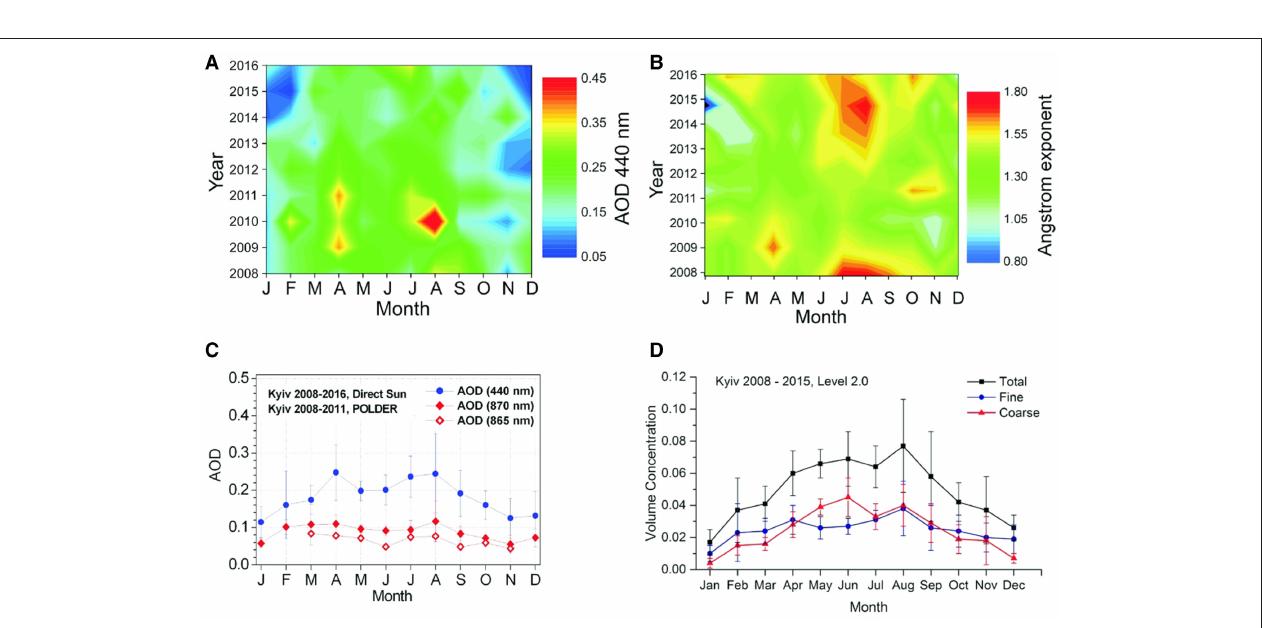
FIGURE 9 | Maps of monthly mean aerosol AOD at 865nm retrieved for the investigated area from measurements of POLDER/PARASOL for April, July, and August in 2010 (A–C) and in 2011 (D–F) . Note the intensive wildfire aerosol products from Moscow region started in July 2010 and rapidly increased in August 2010. Data credit: